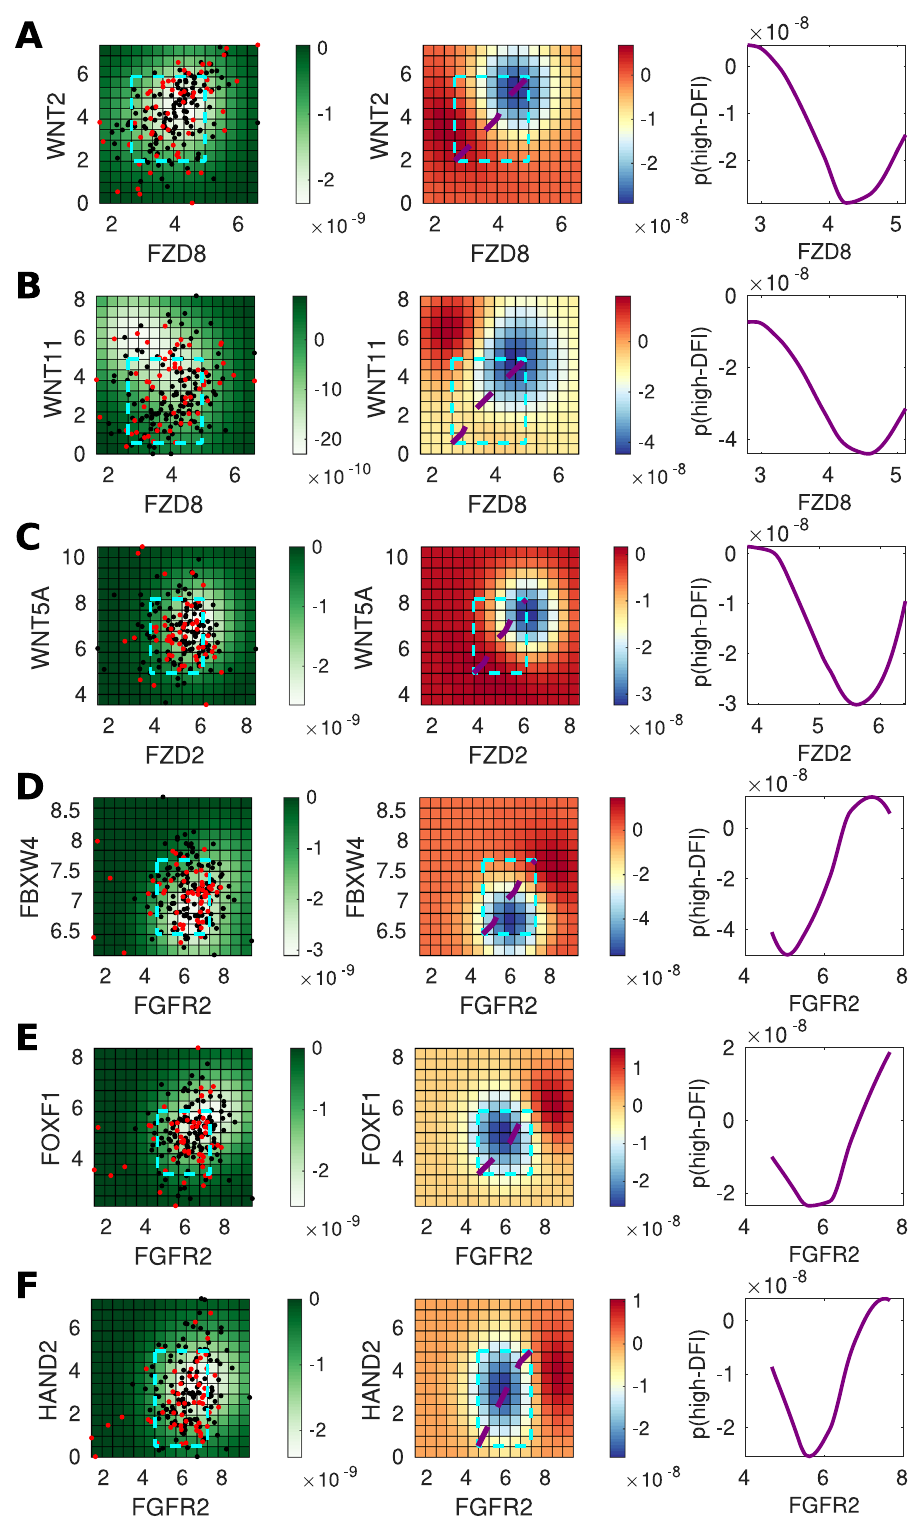
Fig. 5 Genes predictive of invasiveness in BLCA. A For gene pair WNT2 and FZD8 , the left panel shows the posterior variance on log – log expression plot of the predicted probability overlaid with patient samples (red = low-DFI, black = high-DFI), 90% con fi dence interval box drawn for standardized expression values (cyan); middle panel: posterior log probability of high-DFI over the same region as left, where the diagonal line (purple) shows the co- expression trend (diagonal line through the 90% CI of standardized expression values); right panel: posterior log probability of high-DFI plotted against the expression of FZD8 , values simulated along the diagonal (purple) corresponding to the middle panel. B As above for WNT11 and FZD8 . C As above for WNT5A and FZD2 . D As above for FBXW4 and FGFR2 . E As above for FOXF1 and FGFR2 . F As above for HAND2 and FGFR2